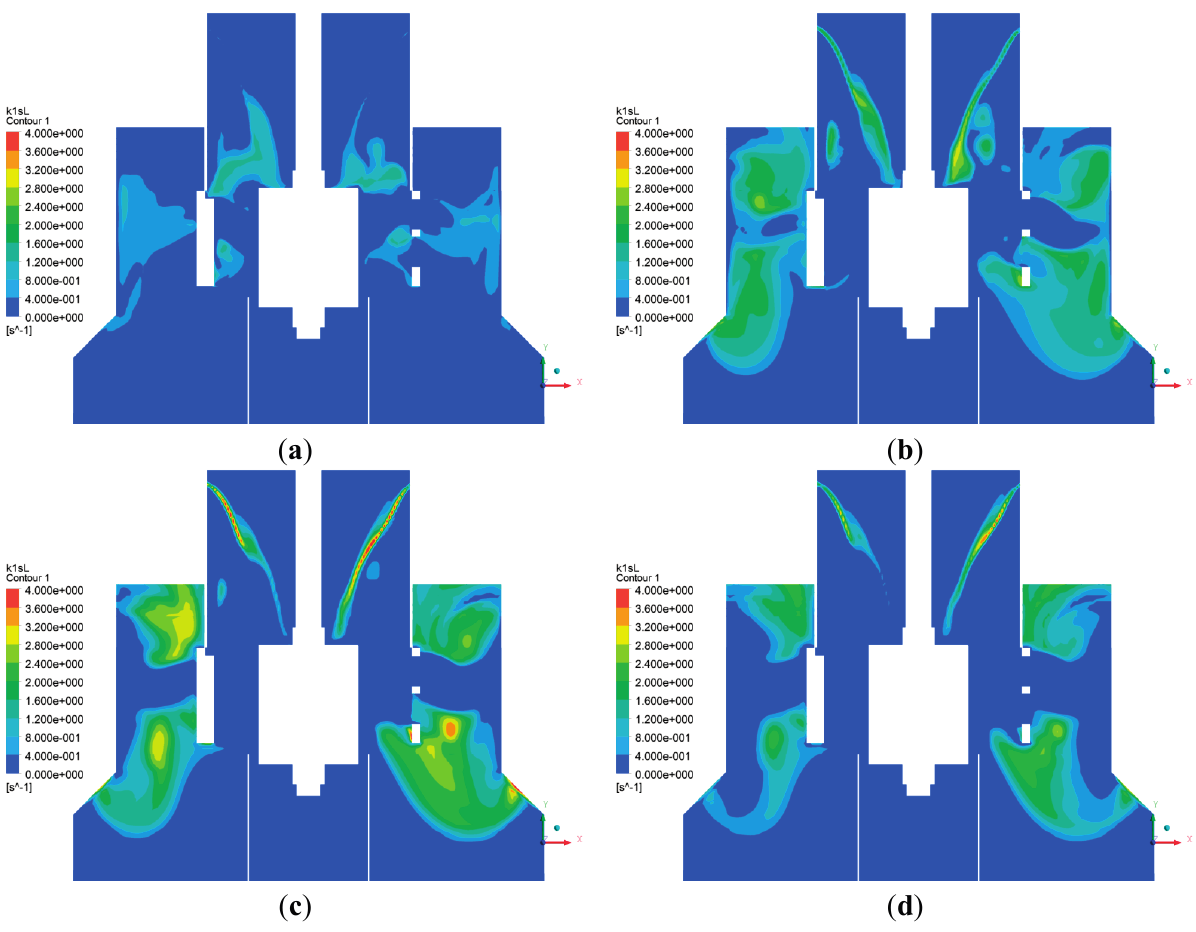
Figure 12. ( a ) Pulp recovery rate (cid:1863) (cid:2869)∗ for 40 μ m particle diameter; ( b ) Pulp recovery rate (cid:1863) (cid:2869)∗ for 100 μ m particle diameter; ( c ) Pulp recovery rate (cid:1863) (cid:2869)∗ for 200 μ m particle diameter; ( d ) Pulp recovery rate (cid:1863) (cid:2869)∗ for 300 μ m particle